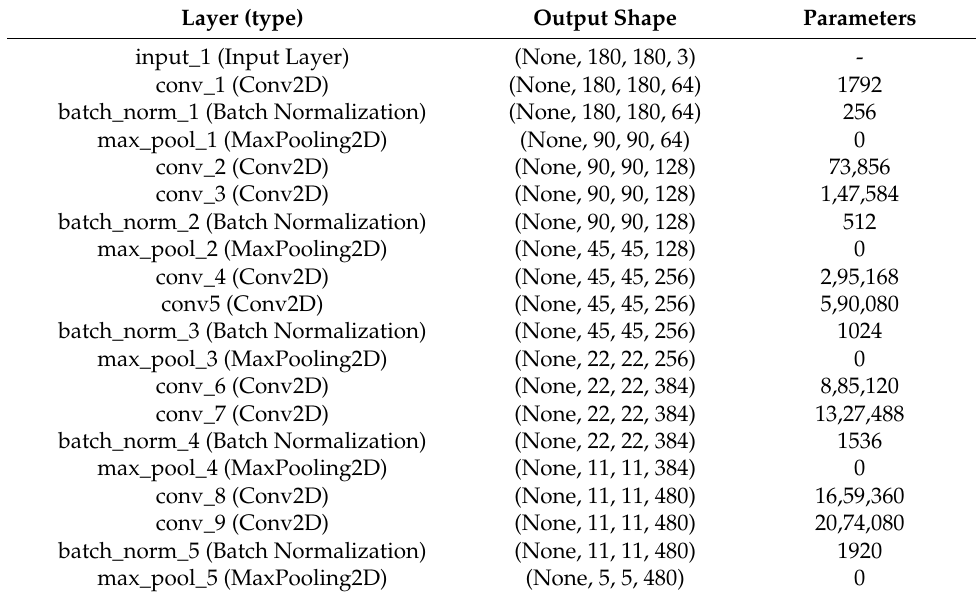
Table 1. Proposed convolutional neural network (CNN) model architecture. Layer